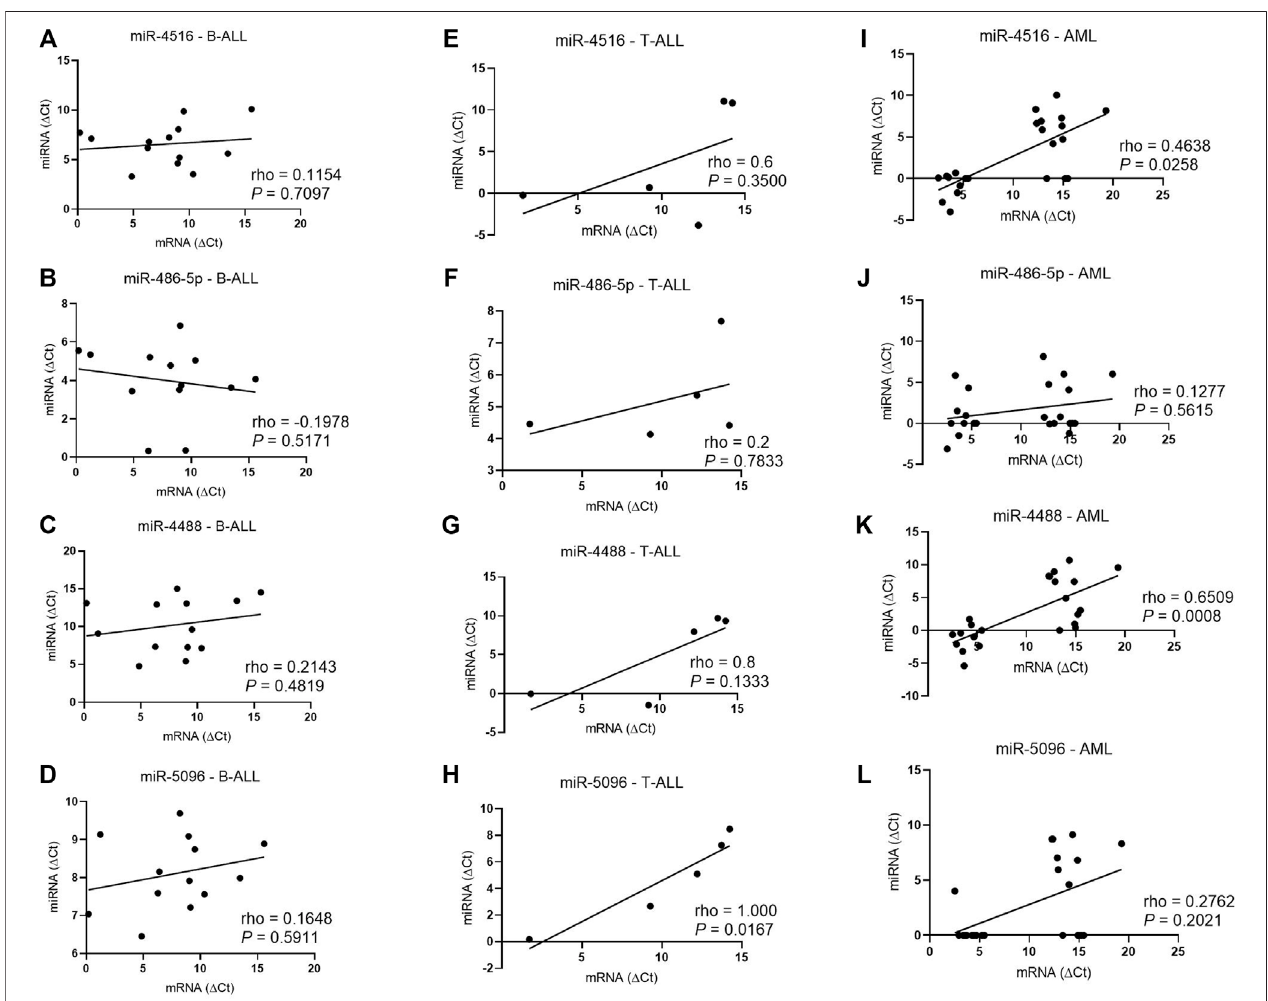
FIGURE 5 | Correlation coef fi cient analysis between miRNAs and HLA-G5 mRNA levels in the bone marrow from patients with untreated leukemia. (A) Correlation coef fi cient analysis between hsa-miR-4516 and HLA-G5 in B-ALL ( n = 13); (B) correlation coef fi cient analysis between hsa-miR-486-5p and HLA-G5 in B-ALL ( n = 13); (C) correlation coef fi cient analysis between hsa-miR-4488 and HLA-G5 in B-ALL ( n = 13); (D) correlation coef fi cient analysis between hsa-miR-5096 and HLA-G5 in B-ALL ( n = 13); (E) correlation coef fi cient analysis between hsa-miR-4516 and HLA-G5 in T-ALL ( n = 5); (F) correlation coef fi cient analysis between hsa-miR-486- 5p and HLA-G5 in T-ALL ( n = 5); (G) correlation coef fi cient analysis between hsa-miR-4488 and HLA-G5 in T-ALL ( n = 5); (H) correlation coef fi cient analysis between hsa-miR-5096 and HLA-G5 in T-ALL ( n = 5); (I) correlation coef fi cient analysis between hsa-miR-4516 and HLA-G5 in AML ( n = 23); (J) correlation coef fi cient analysis between hsa-miR-486-5p and HLA-G5 in AML ( n = 23); (K) correlation coef fi cient analysis between hsa-miR-4488 and HLA-G5 in AML ( n = 23); and (L) correlation coef fi cient analysis between hsa-miR-5096 and HLA-G5 in AML ( n = 23). For the correlation analysis, the Spearman ’ s correlation coef fi cient was